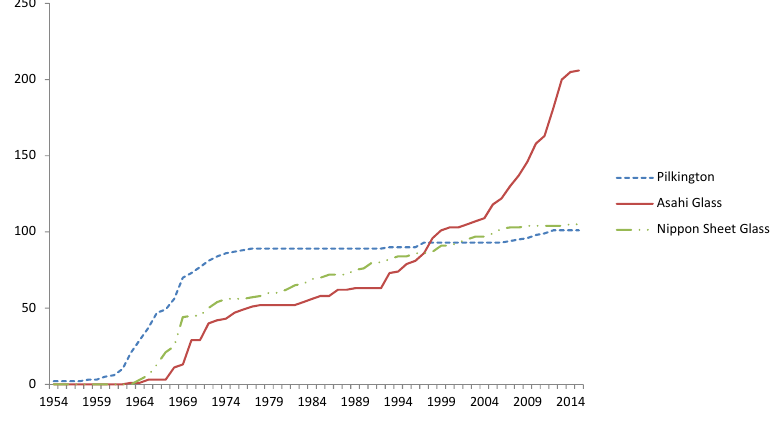
Figure 3. Comparison of Pilkington and two Japanese firms Source: Created by author from J-PlatPat search